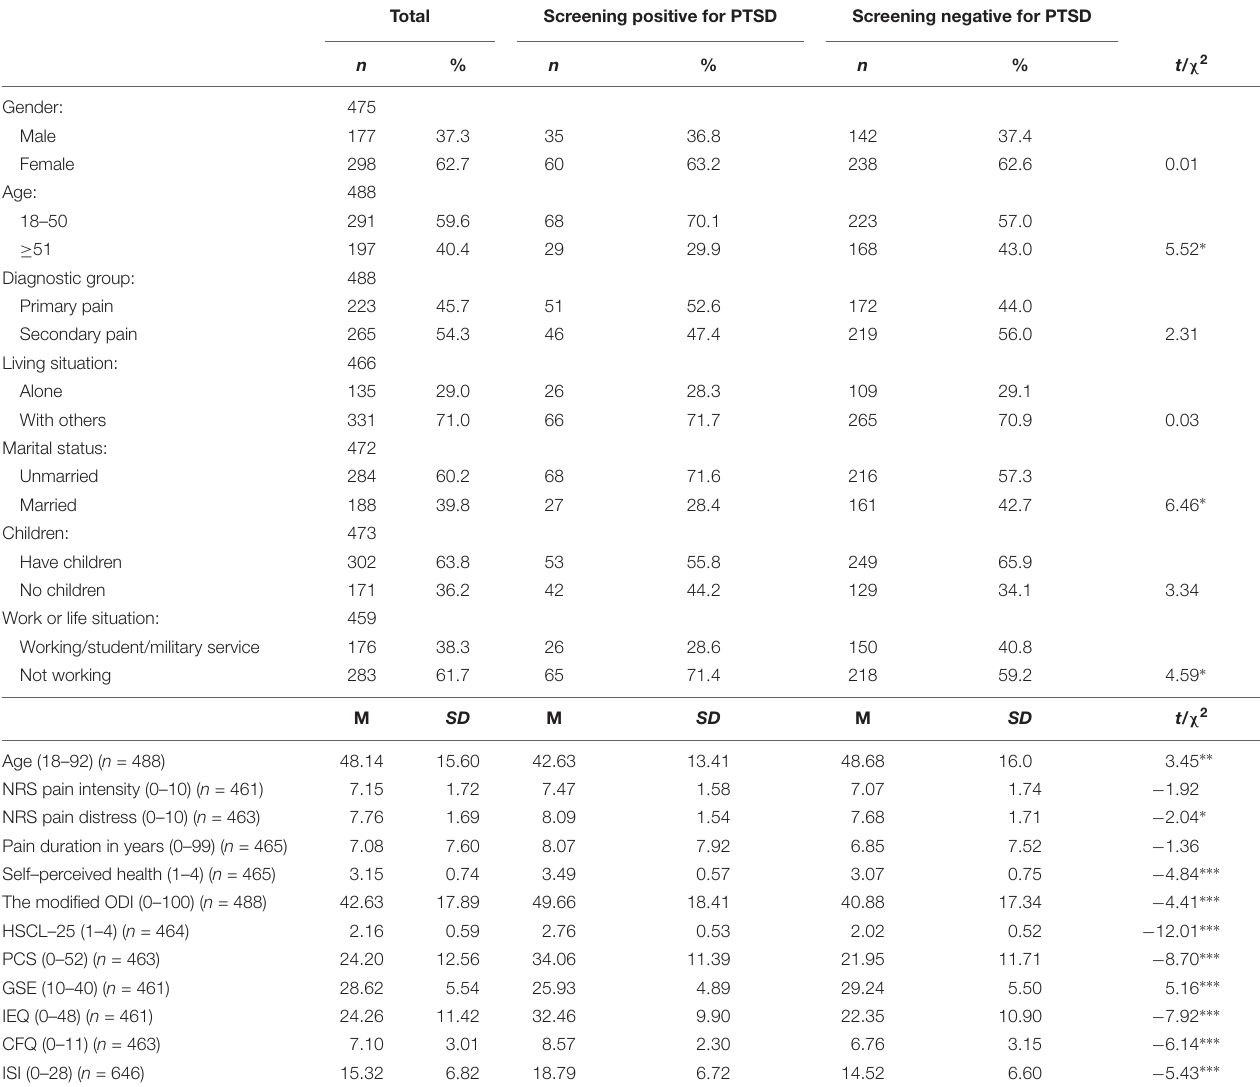
TABLE 3 | Chi-squared- and t -tests showing the differences between chronic pain patients screening positive and negative for PTSS at a level qualifying for a PTSD diagnosis in the second wave of data collection. Total Screening positive for PTSD Screening negative for